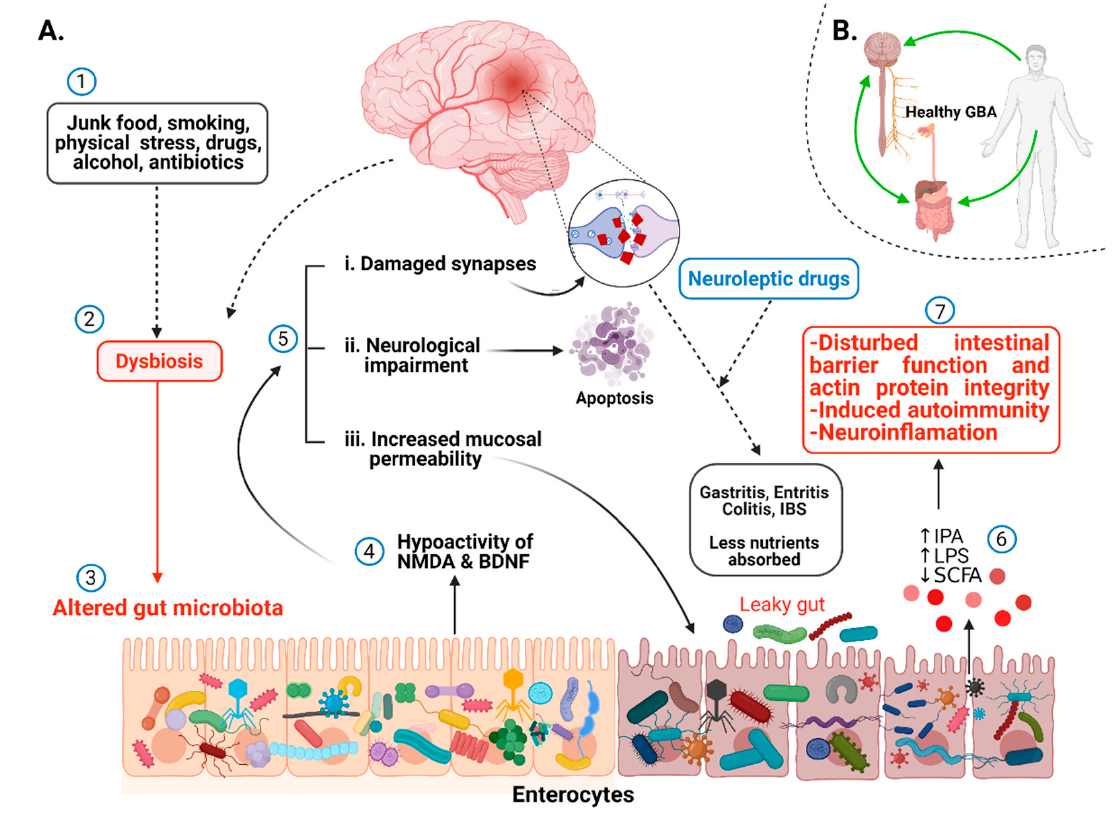
Figure 3. Communication between the gut microbiota and brain in schizophrenia. ( A ): (1) Junk food, frequent use of drugs, lack of exercise result in gut microbial dysbiosis. (2) Gut microbial dysbiosis means alteration in gut microbial species. (3) Decrease in healthy gut microbiota and increase in pathogenic species. (4) Direct influence of altered gut microbes causes the hypoactivity of NMDA and BDNF receptors. (5) Hypoactivity of NMDA and BDNF receptors results in damaged synapsis, neurological impairments, and increased intestinal membrane permeability as indicated by solid arrows. Consequently, abolishment of spinogenesis, gastritis, enteritis, colitis, and irritable bowel syndrome occurs (indicated by dotted arrows). (6) Altered microbial products such as indole propionic acid (IPA), lipopolysaccharides (LPS), and short-chain fatty acids (SCFA). (7) Anomalous expression of microbial products leads to dysfunction of the intestinal barrier as well as induces autoimmunity and neuroinflammation. ( B ): Normal gut microbiota is crucial to maintain the gut–brain axis.